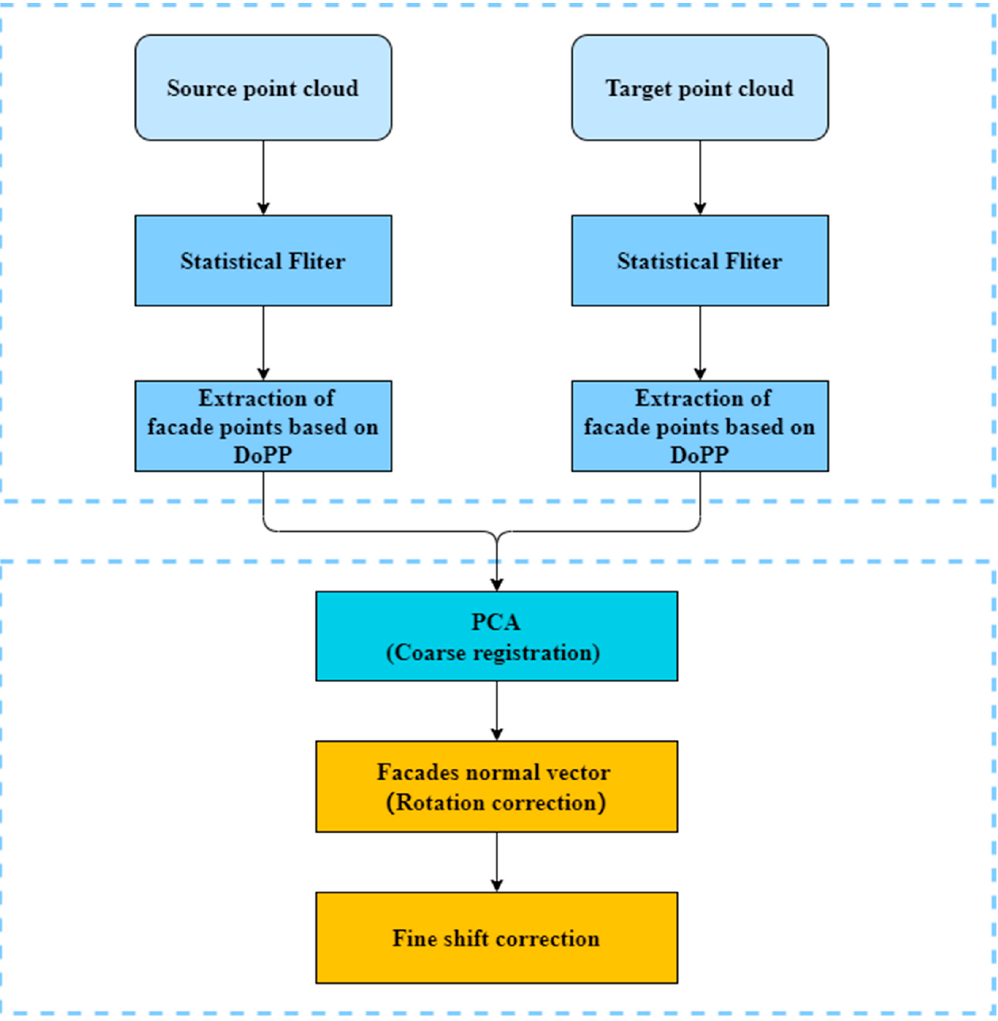
Figure 2. Flowchart of the proposed method. The rectangular box in the upper half represents the preprocessing of the data: filtering and extraction of building elevation points. The rectangular box in the lower half represents the step of data alignment: coarse alignment followed by rotation and fine translation